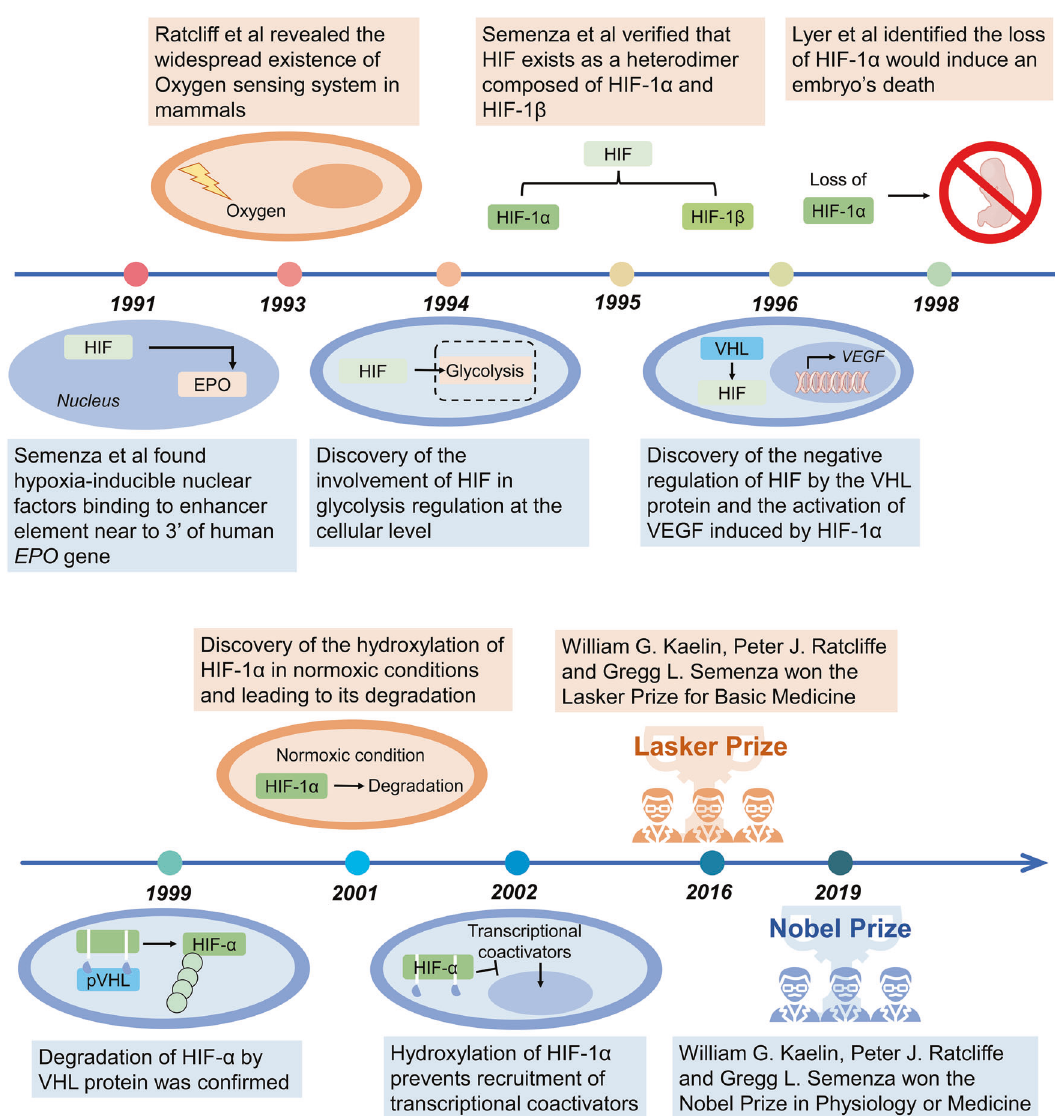
Fig. 1 History and events of the studies on hypoxia signaling. A glance of the discoverty and advance of the knownlegment of hypoxia signaling started from 1991. In 2019, the Nobel Prize in Physiology and Medicine was awarded for the discovery of cellular mechanisms for oxygen sensing in